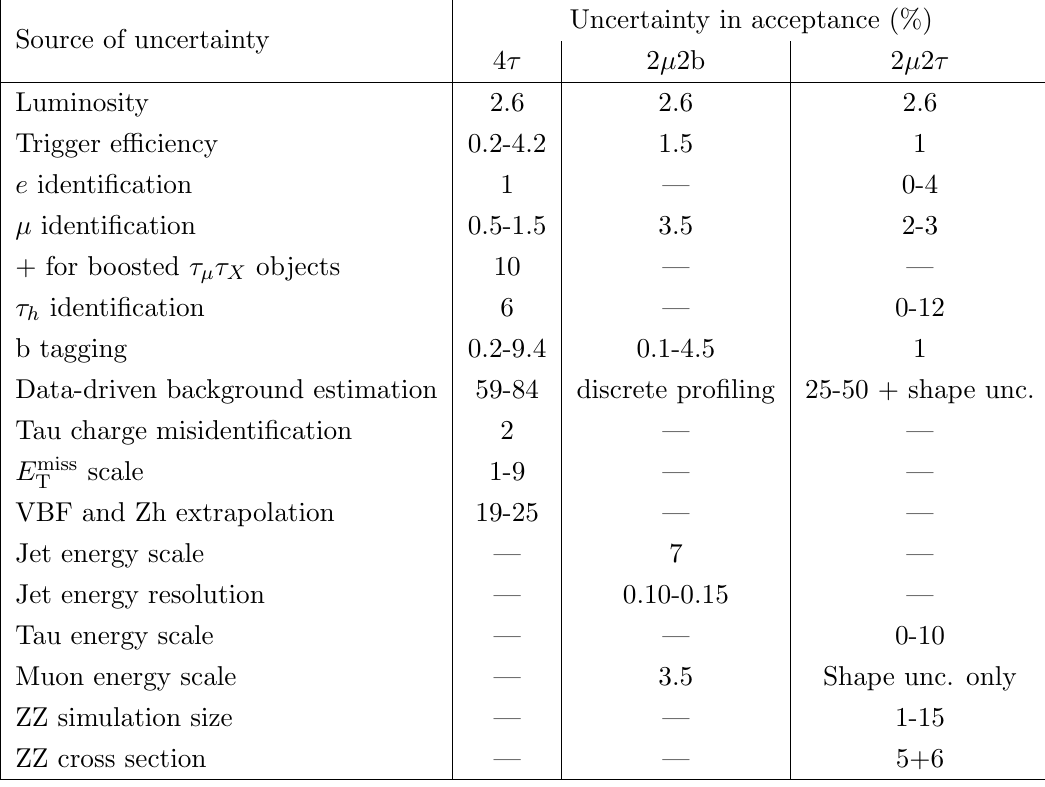
Table 6 . Sources of systematic uncertainties, and their e(cid:11)ects on process yields, for the three di(cid:11)erent searches.